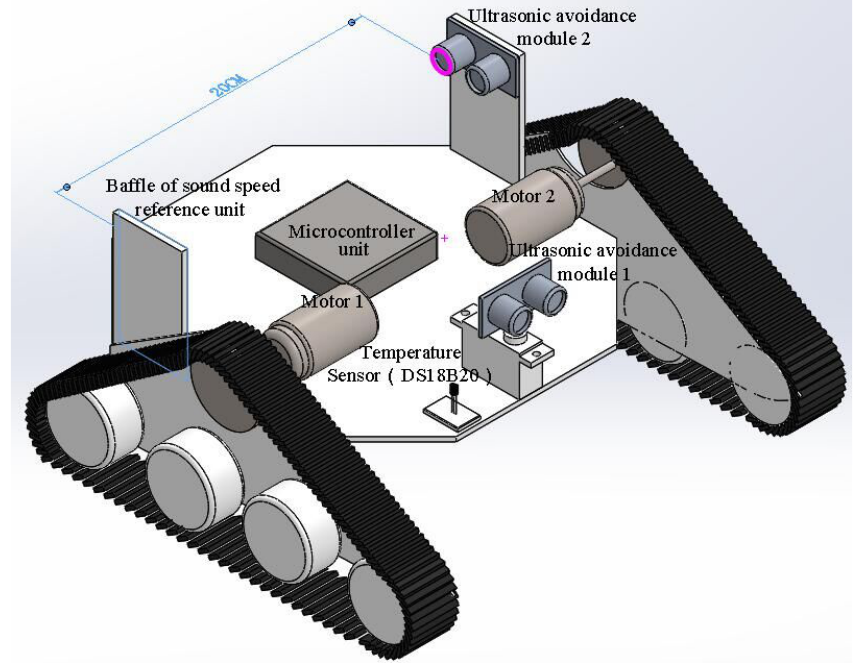
Figure 2. Guided vehicle based on the proposed baffle calibration method.